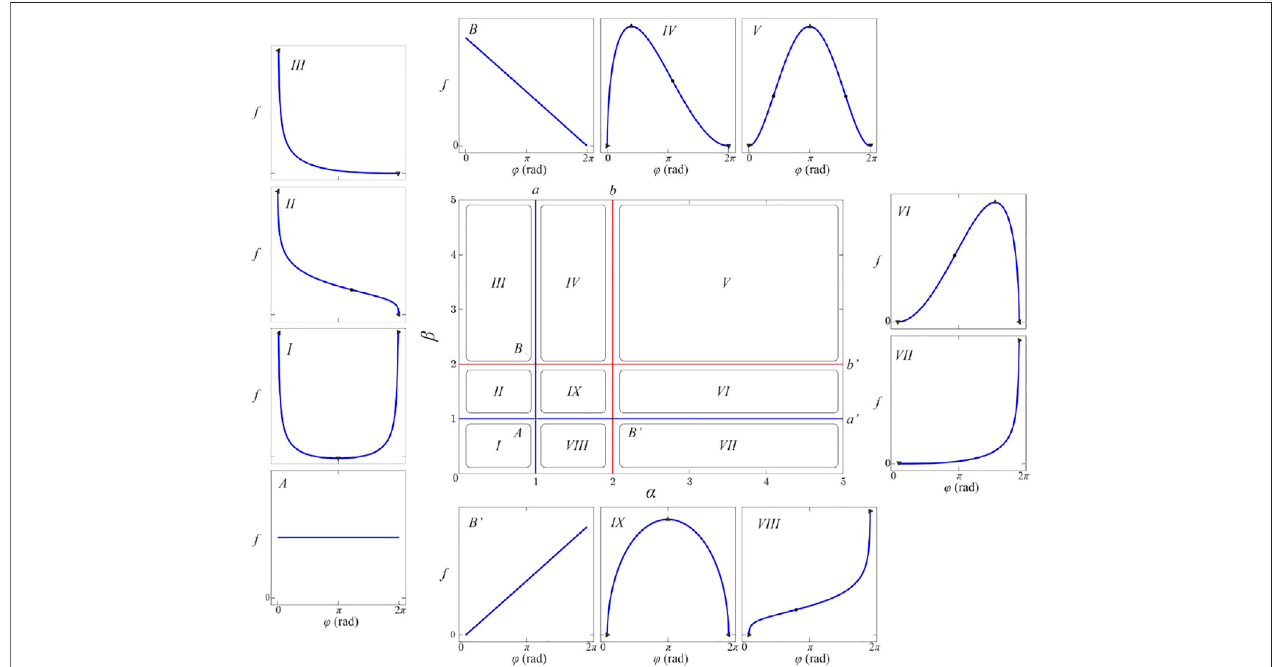
FIGURE4| (coloronline)Theshapediagramofthebeta-distribution.InsetslabeledbyRomannumerals I-IX showtheshapeofthebeta-distributionforparameters fromthecorrespondingsubspaceslabeledbythesamesymbol.Thecharacteristiclines a , a ′ ,and b , b ′ areshownbytheblueandredlines,respectively.Points A , B , B ′ , correspond to the parameter values for which function f is proportional to the constant, and linear functions, respectively. Horizontal critical points of the function f were indicated by symbols ▲ and ▼ , while ascending and descending vertical critical points were denoted by symbols ► and ◄ .